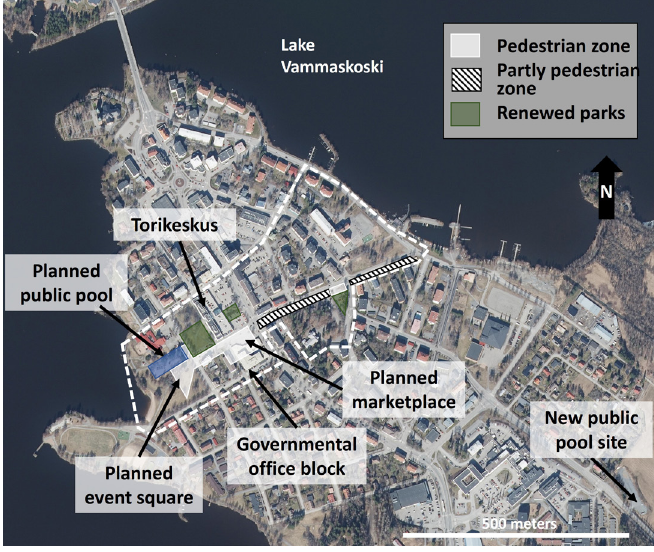
Fig. 7. Planned downtown area in Sastamala (Background: Maanmittauslaitos Ortokuva